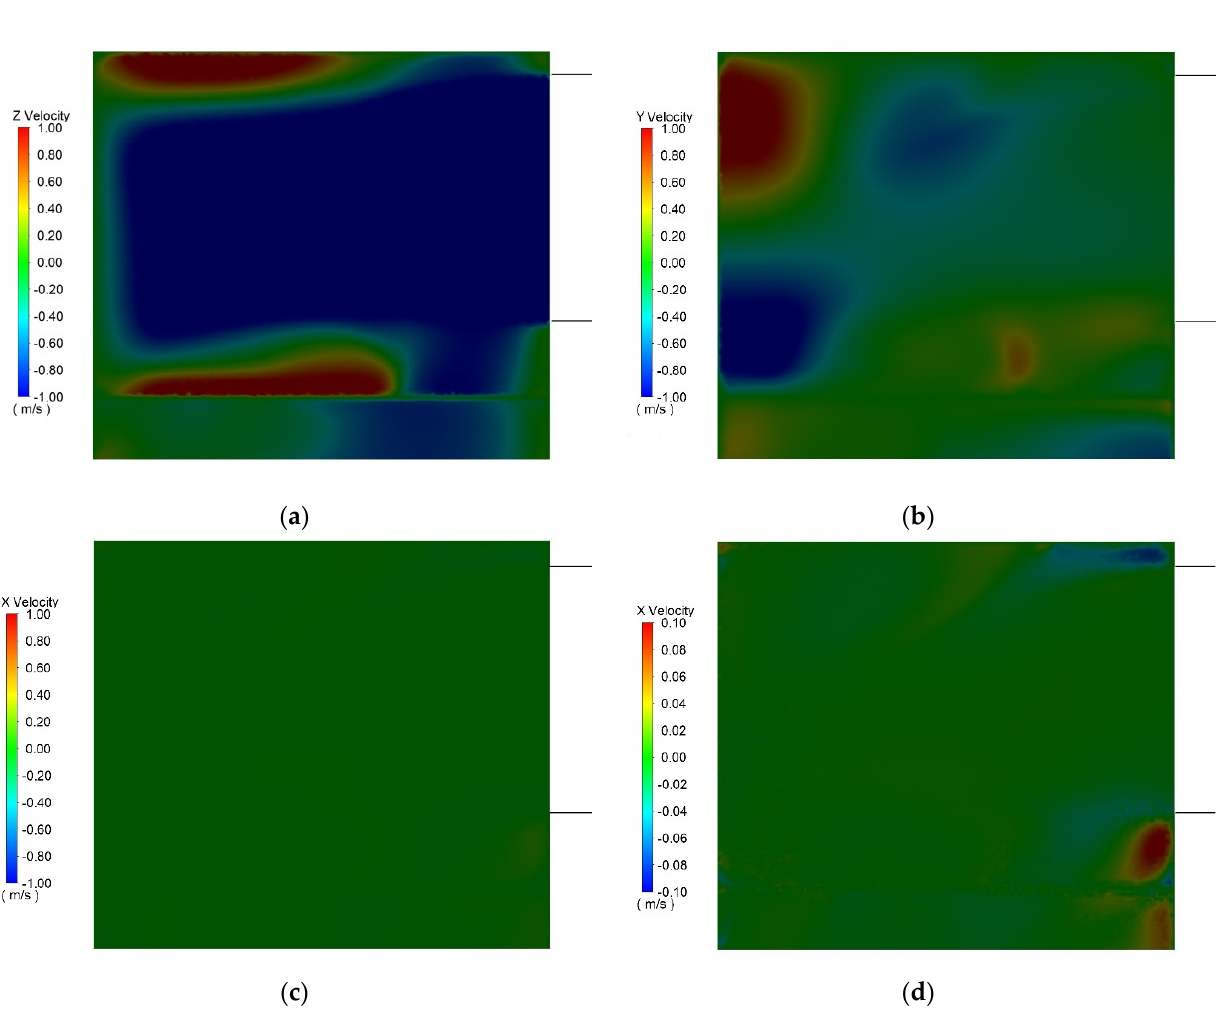
Figure 13. Distribution of v x , v y , and v z velocity components in the Z-Y plane passing through the center of the spigot of the plenum box with side entry (X = 0 mm) ( a ) in the Z direction; ( b ) in the Y direction; ( c ) in the X direction; and ( d ) in the X direction with limited scale of